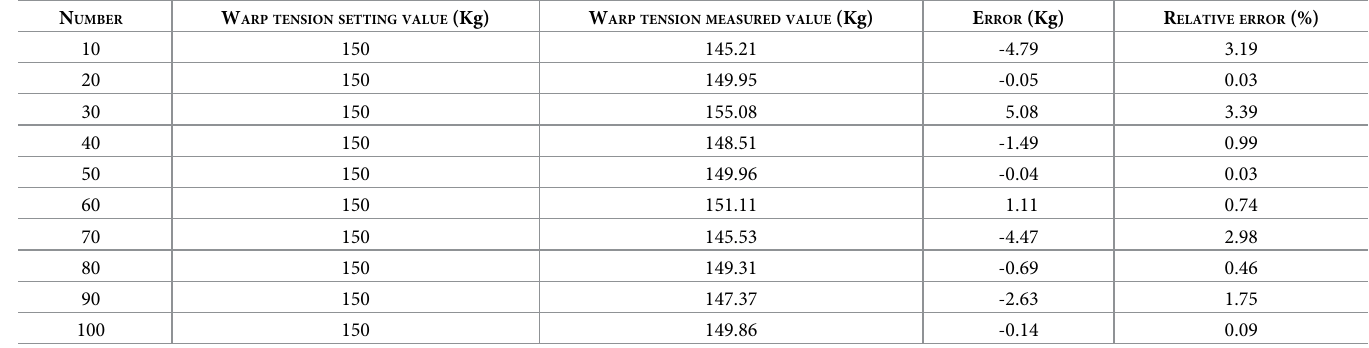
Table 2. The actual warp tension measured by genetic PID algorithm and its error comparison table.